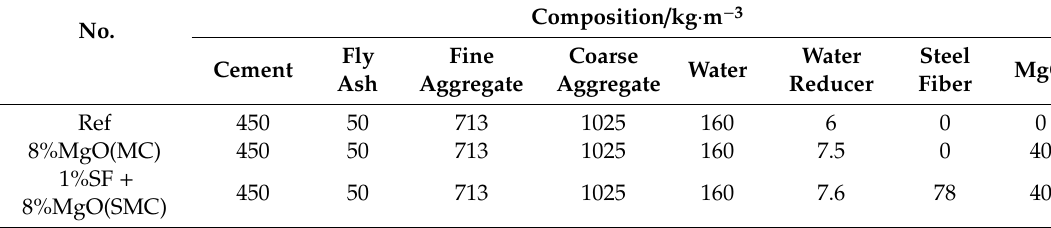
Table 3. Mix proportion of